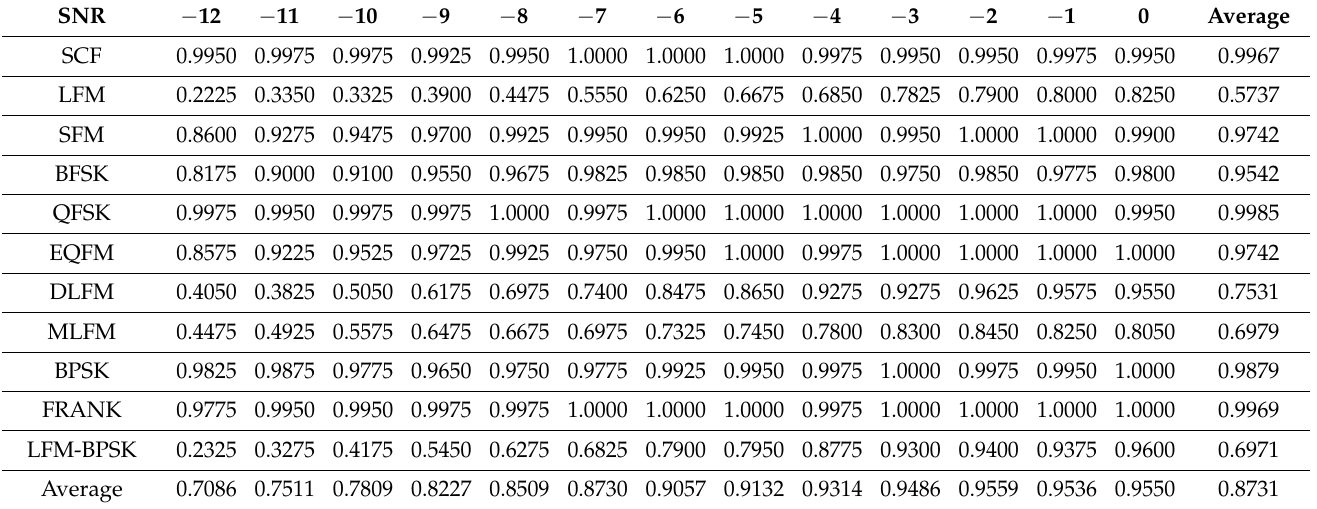
Table A9. Semi-supervised classification results with the datasets in Situation Dataset 5 ( T cycle = 50, NUM =